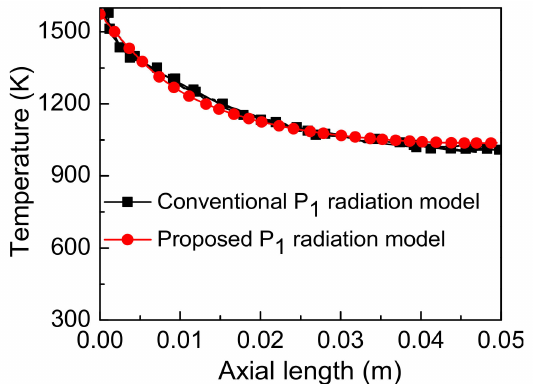
Figure 3. Temperature distribution compared to the Reference [34] under 170 kW / m 2 radiation heat flux applied on quartz glass at 8.64 L / h inflow laminar and 1